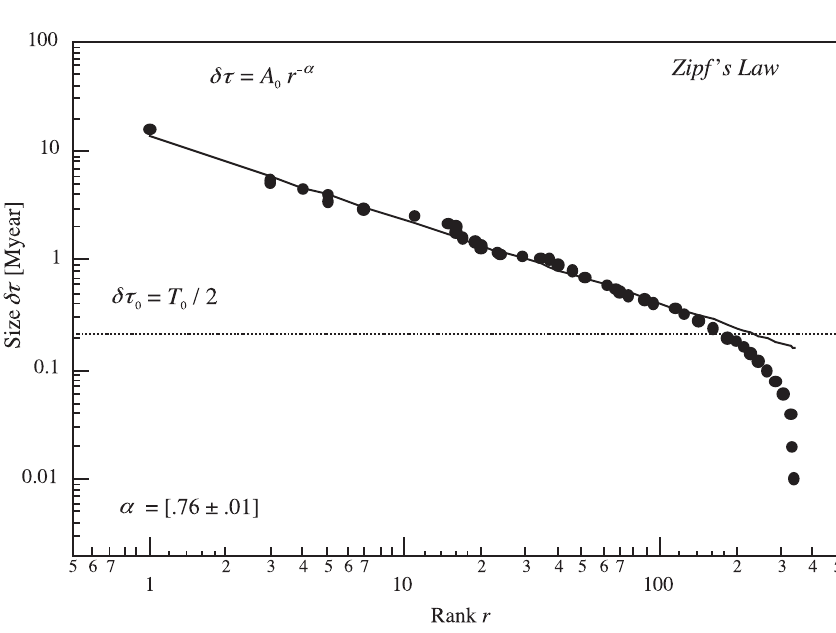
Fig. 3. The ranking distribution relative to the polarity time intervals. The solid line is a nonlinear power-law best fi t. The horizontal dotted line indicates the characteristic time-scale evaluated on the basis of the PSD (see